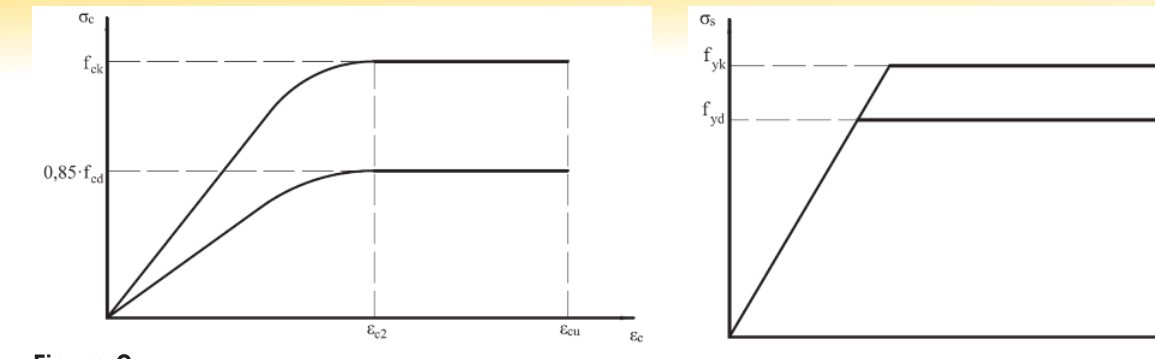
Stress-strain relationship for non-prestressed steel reinforcement